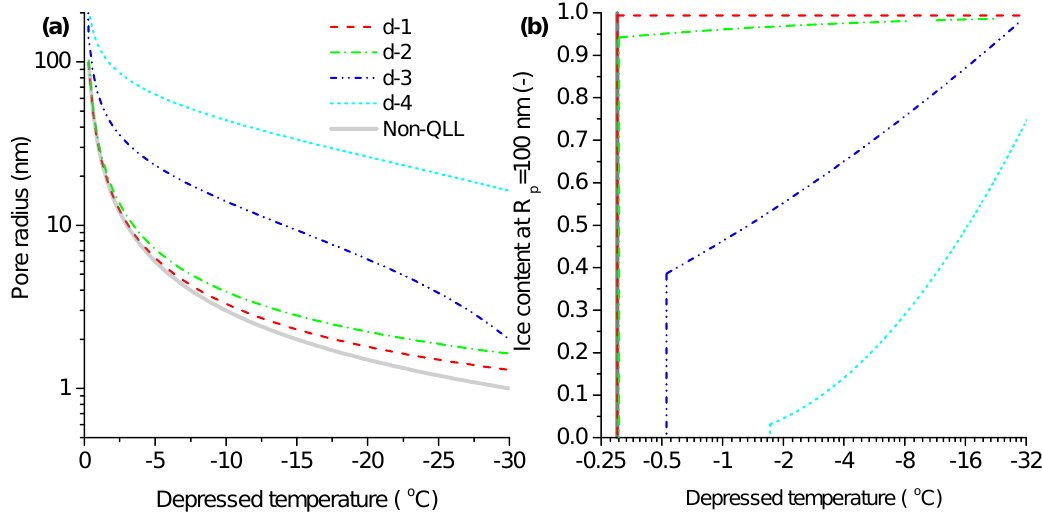
Figure 3. ( a ) The plots of pore radius against depressed temperature predicted by the Gibbs–Thompson (GT) equation with different datasets of QLL thickness; ( b ) the variation of ice content with depressed temperature in the pore of 100